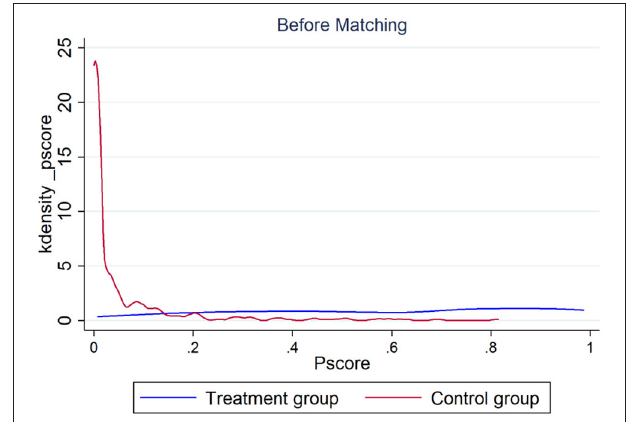
FIGURE 5 | Kernel density distribution of the propensity score before matching.